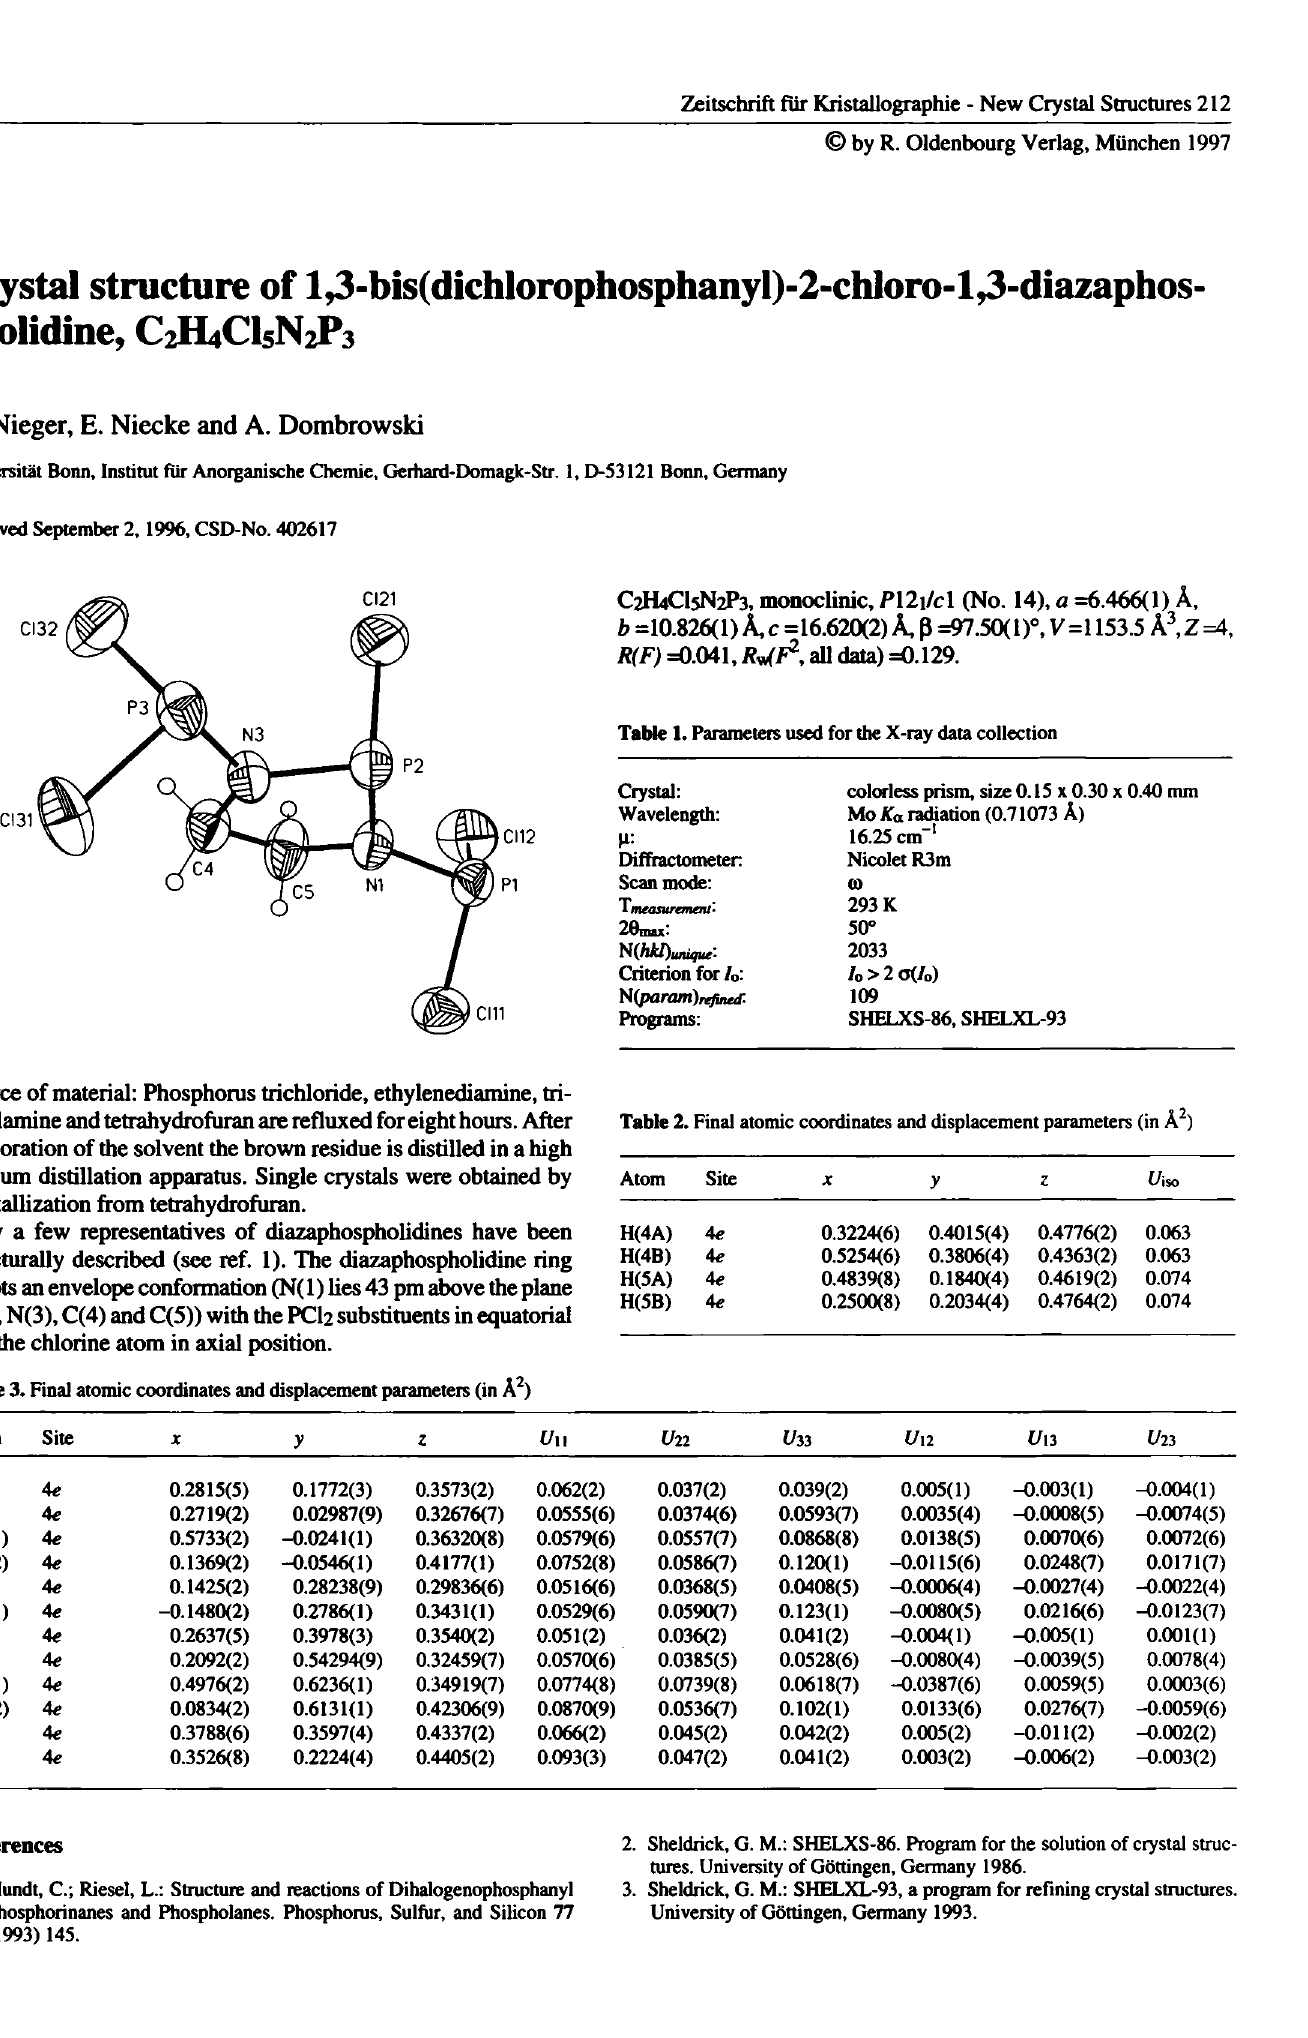
Table 1. Parameters used for the X-ray data collection